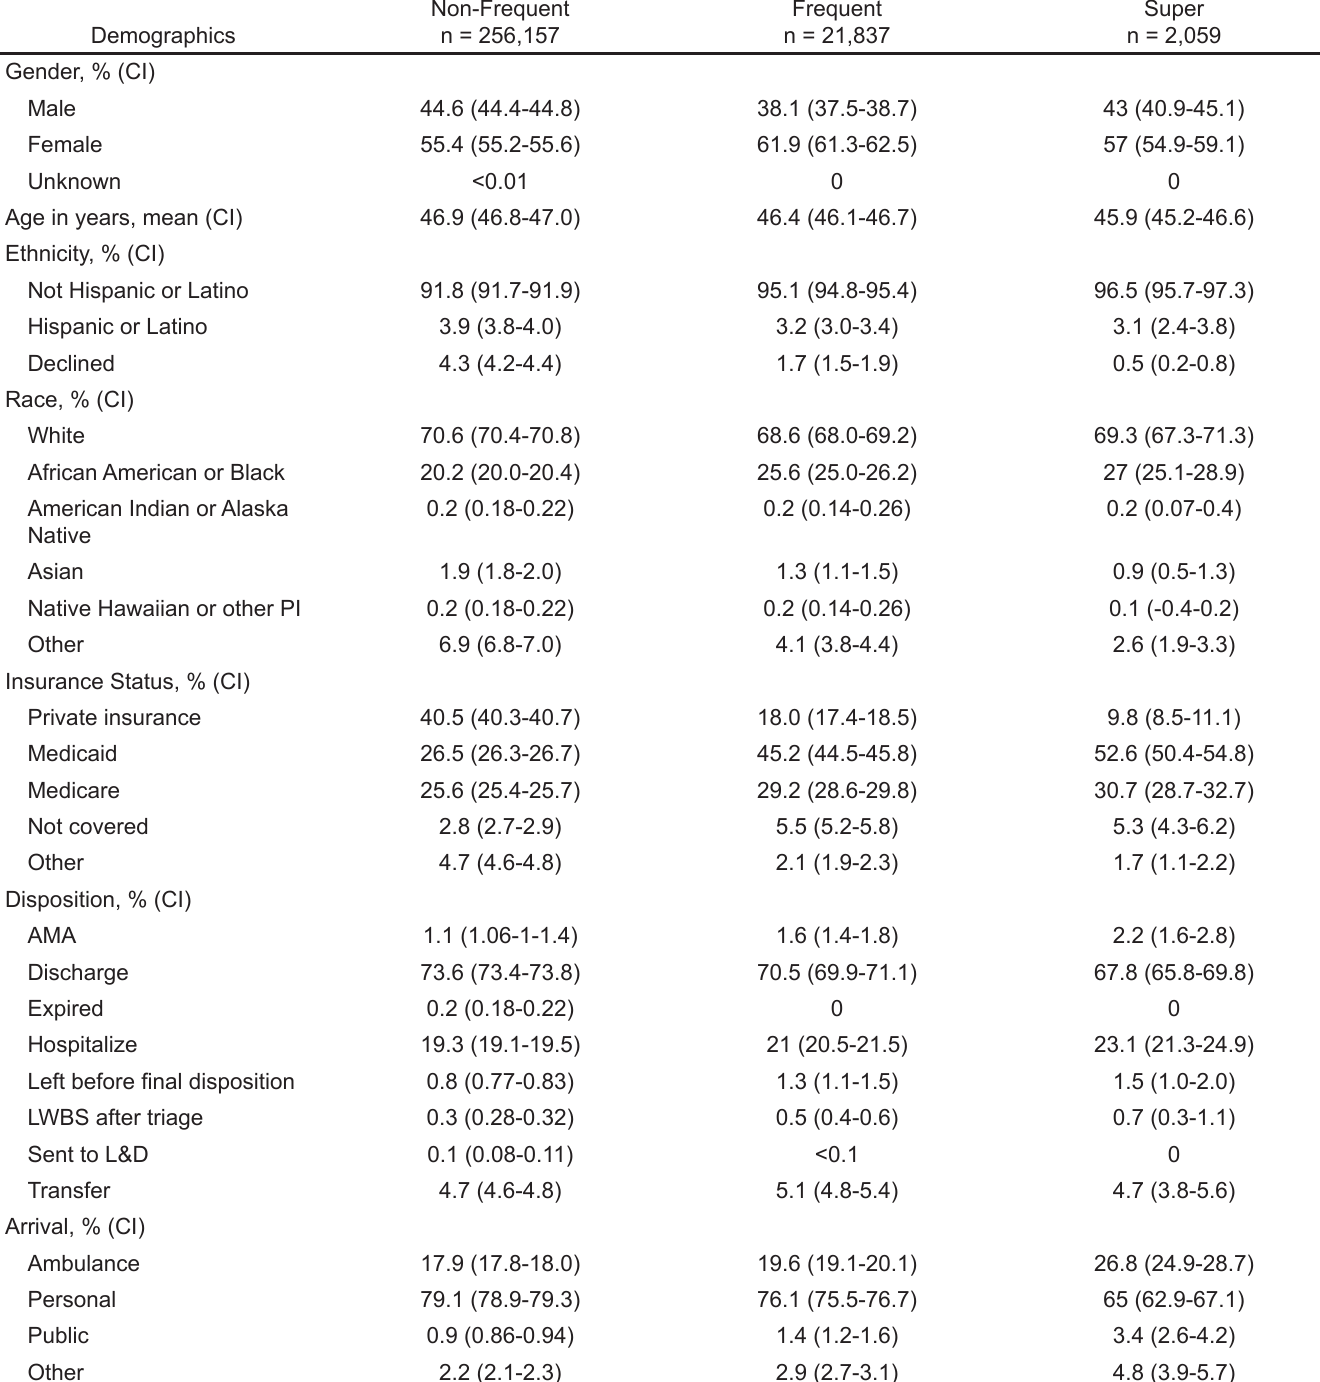
Table 2. Emergency department usage